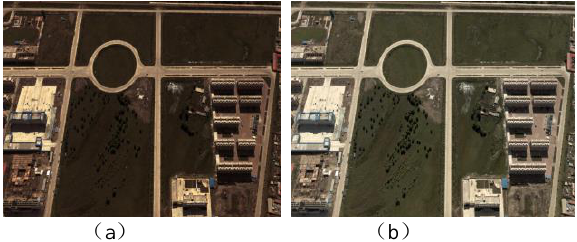
Figure 6 ． Contrast the image(a) before and (b) after saturation